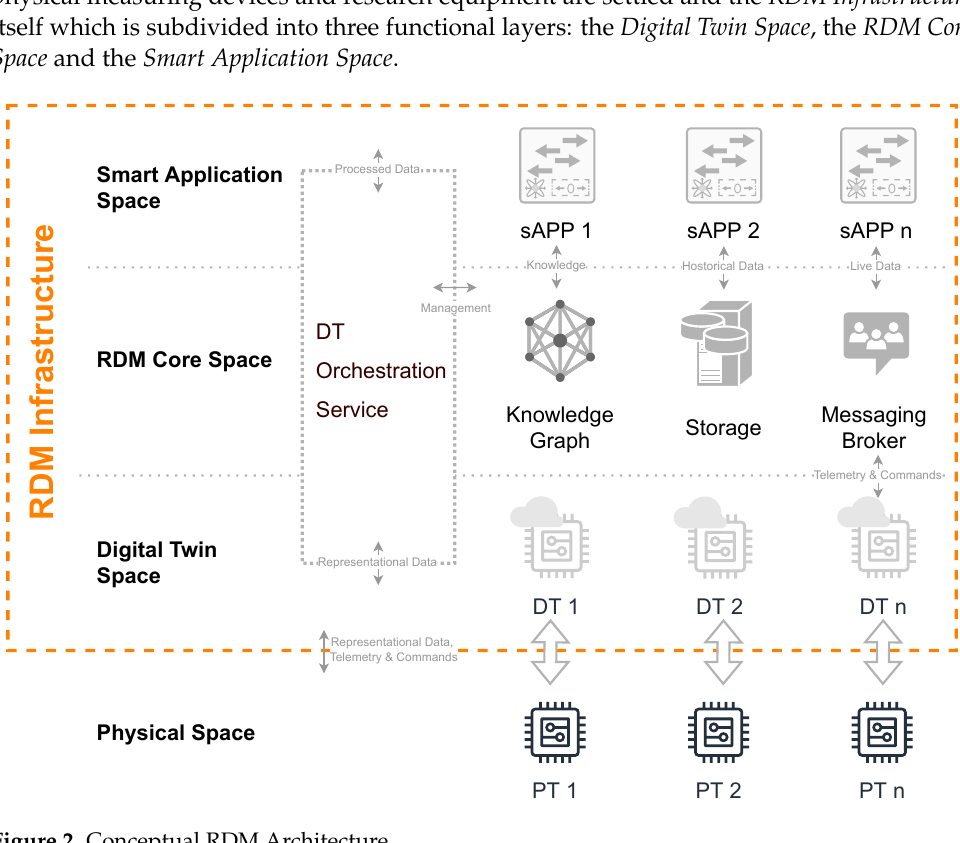
Figure 2. Conceptual RDM